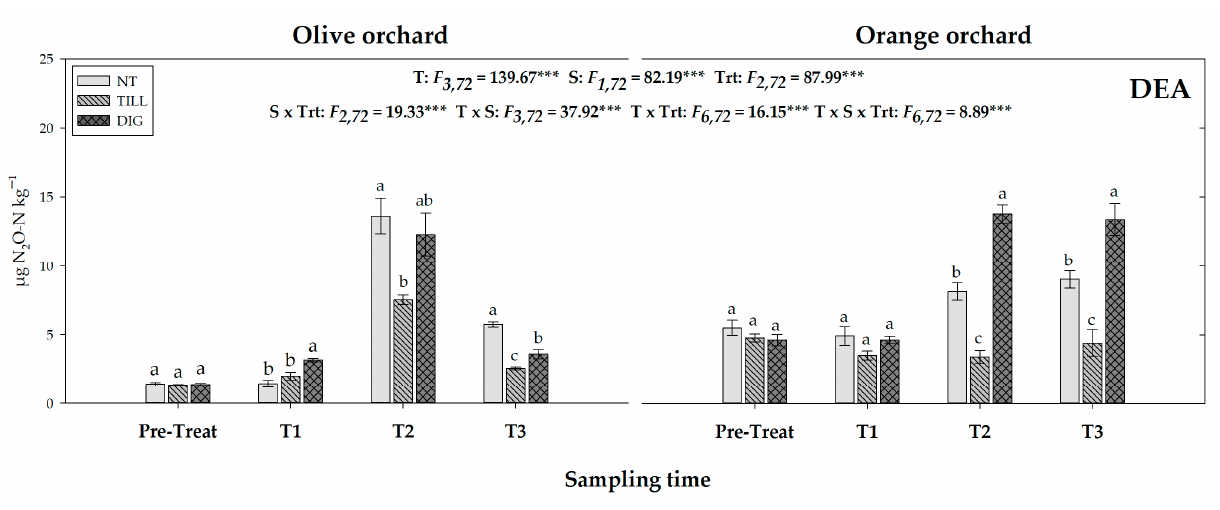
Figure 4. Changes in soil denitrifying enzymatic activity (DEA) (mean ± SD, n = 4) in the field plots arranged in an olive and an orange orchard under different treatments—no-tillage (NT), conventional tillage (TILL), solid anaerobic digestate amendment (DIG)—at four sampling times (from May to September) during the 2016 growing season. Within each sampling period, different letters indicate significant differences among treatments (Tukey’s HSD test, p < 0.05). Significant effects due to time (T), soil type (S), soil management (Trt), and their interactions are presented as F-values, and level of significance (* p < 0.05, ** p < 0.01, *** p < 0.001) was estimated by a three-way ANOVA (time × soil × management).